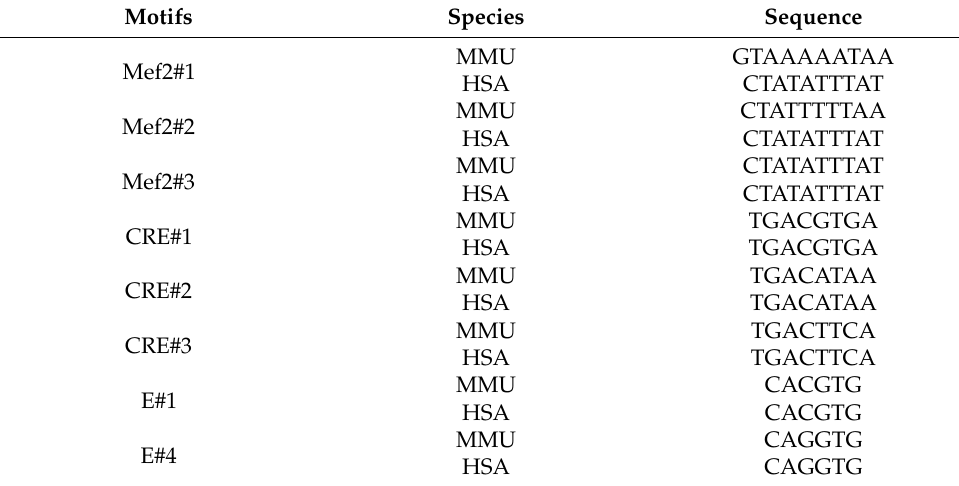
Table 1. Mef2, CRE and E-box motifs of the Tceal7 promoter.